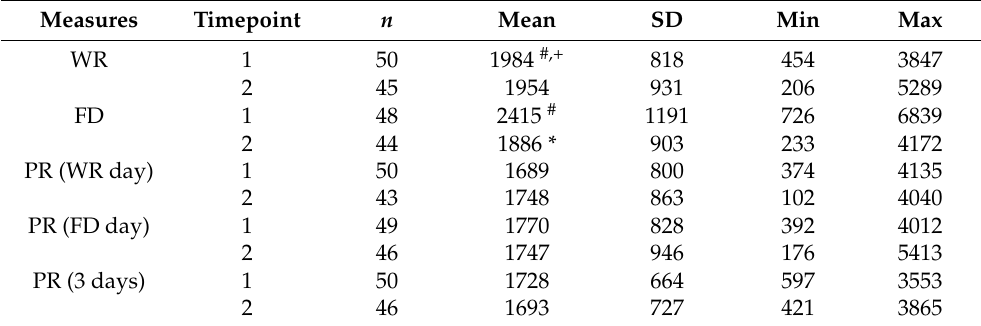
Table 5. Mean energy intake (kcal/day) using different dietary assessment methods at timepoint 1 and 2.